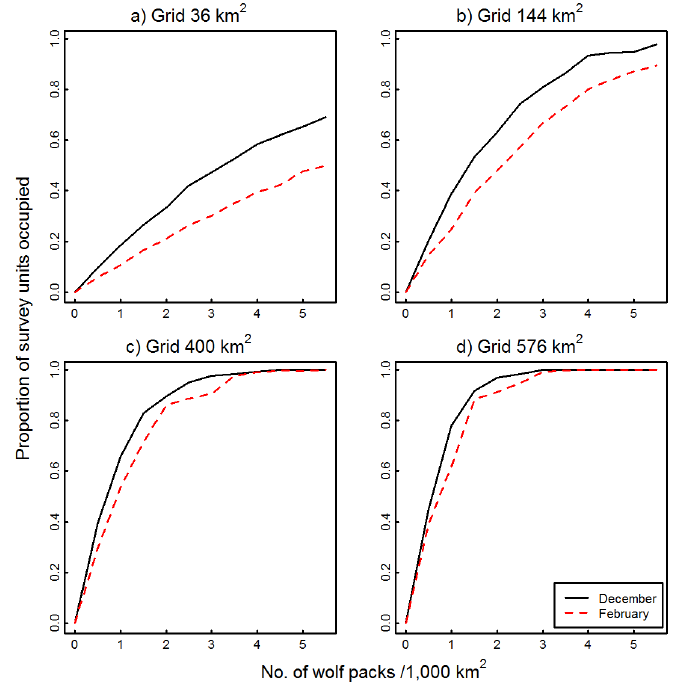
Figure 1. Effects of variation in wolf movement rate on occupancy – abundance relationships. Occupancy–abundance relationships were estimated from the proportion of survey units in which wolf tracks were detected during simulated aerial surveys as a function of wolf pack density (No. packs/1,000 km 2 ). Wolf movements were based on February (short movements) or December (long movements) step length and turn angle distributions from 2-hour GPS locations from 11 wolves, northeastern Alberta, Canada, 2006–2008. Simulations were run for four grids: (a) 36 km 2 , (b) 144 km 2 , (c) 400 km 2 , and (d) 576 km 2 .